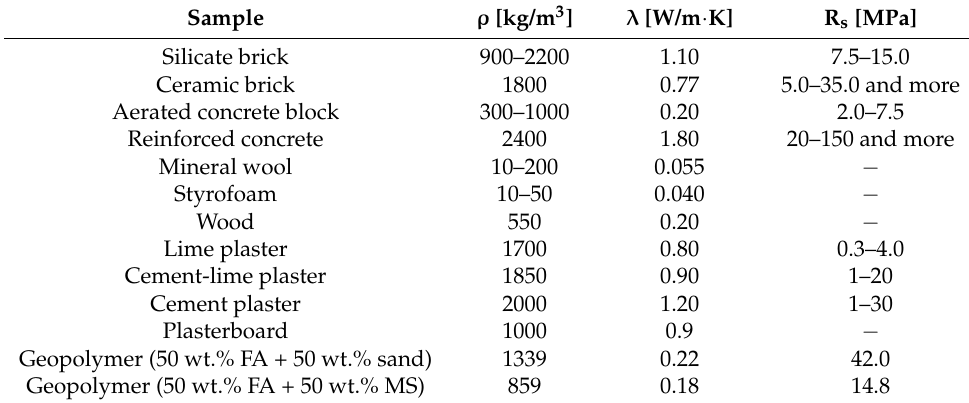
Table 5. Properties of selected building materials. Part of data from Ref.